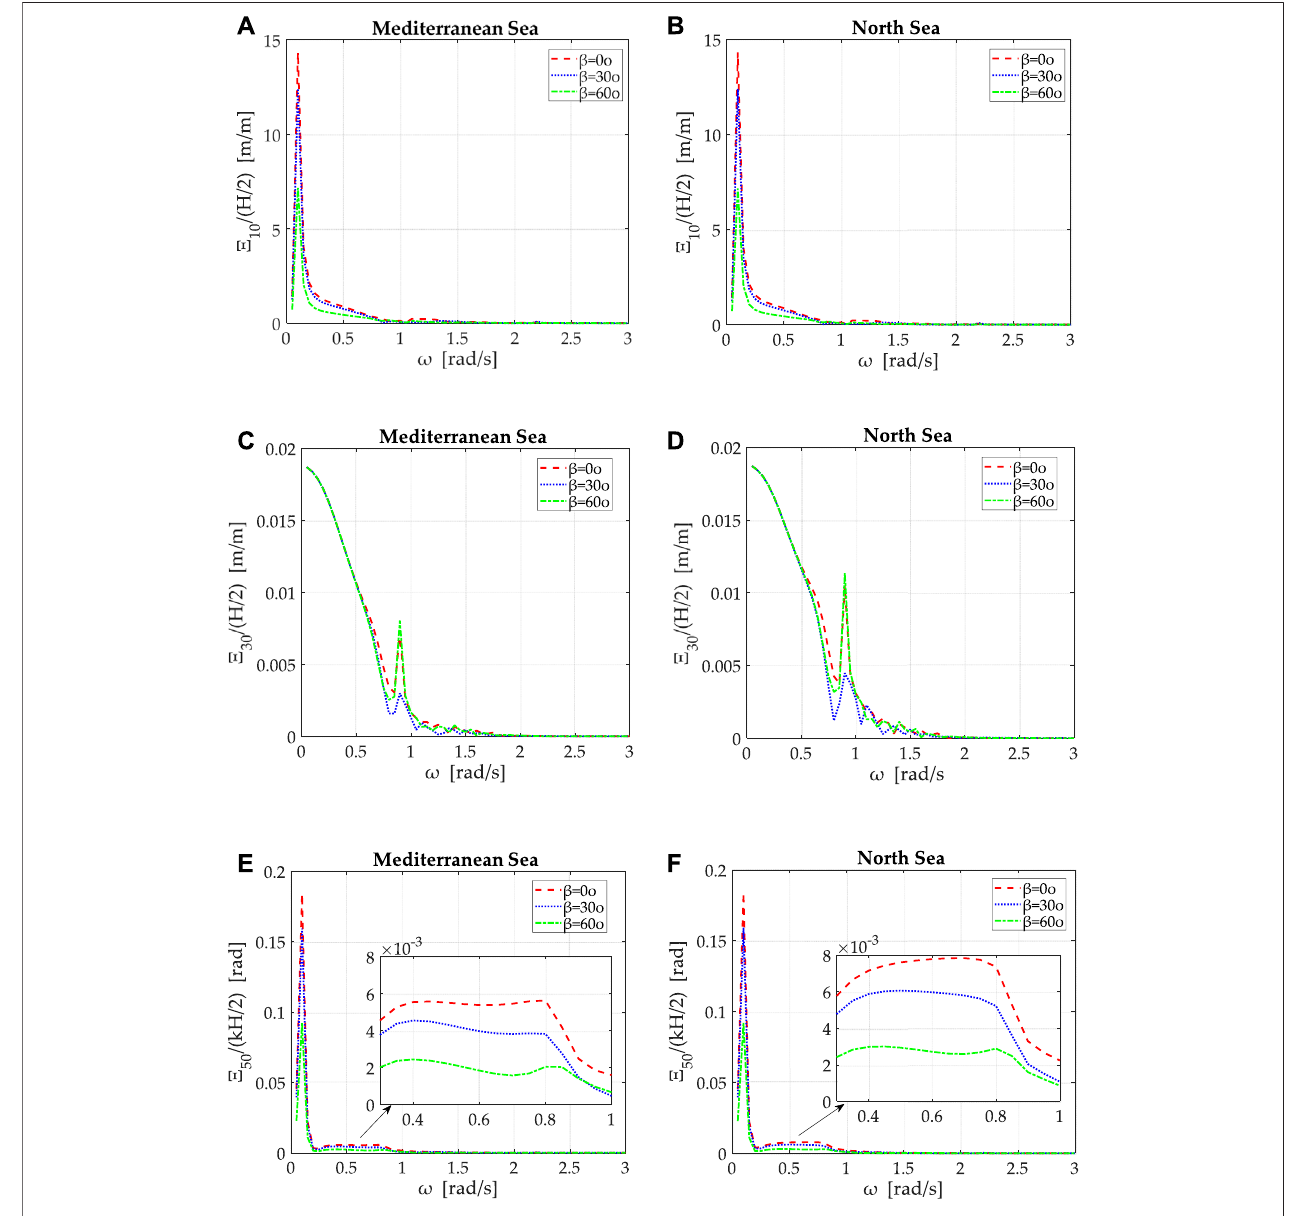
FIGURE 8 | Non-dimensional translational and rotational motions of the hybrid structure at candidate installation sites, for wave angles 0, 30, 60 ° versus wave frequency: (A) , (B) Ξ 10 / ( H